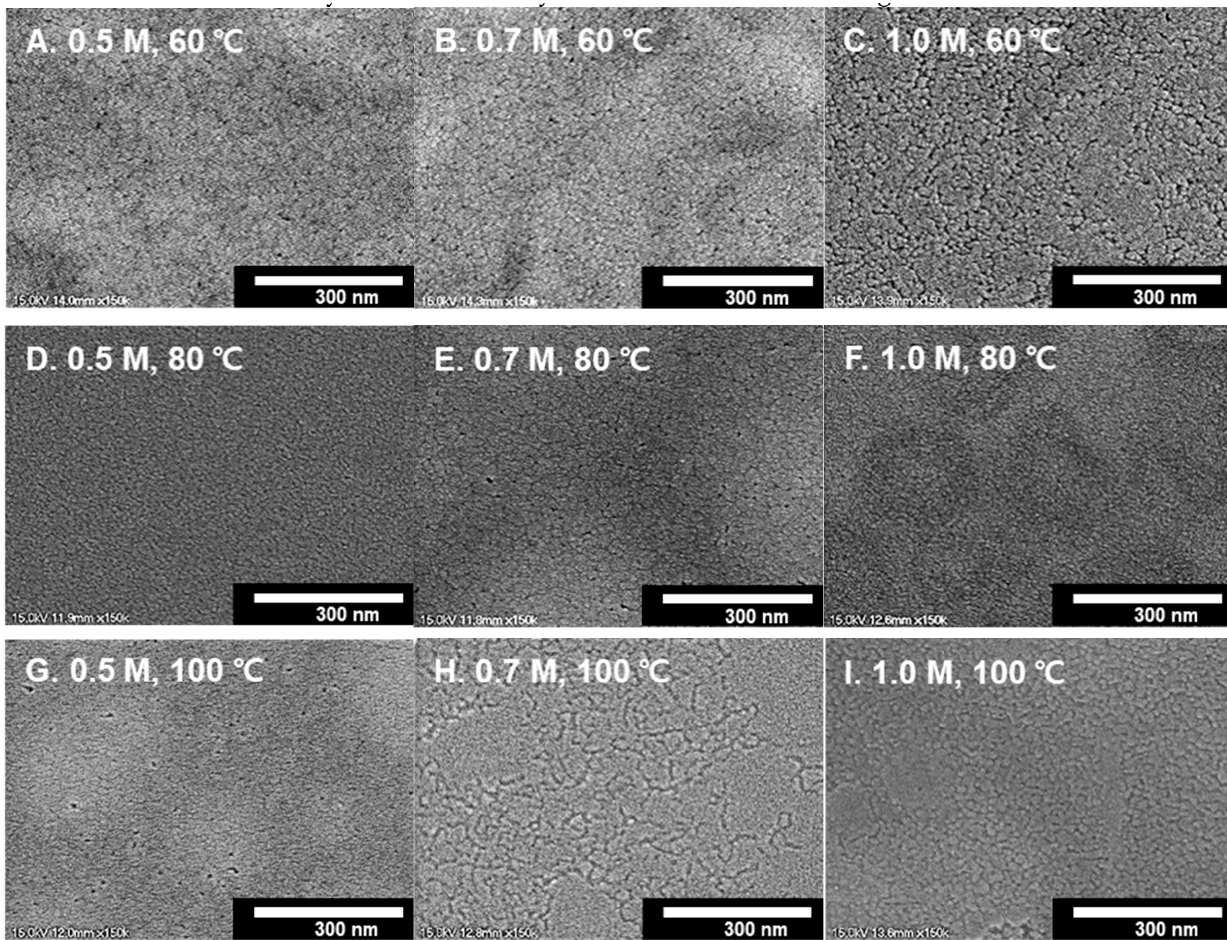
Figure 3. Strain of the β‐ Ga 2 O 3 films fabricated using solutions of different molar concentrations at drying temperatures of 80 and 100 °C.